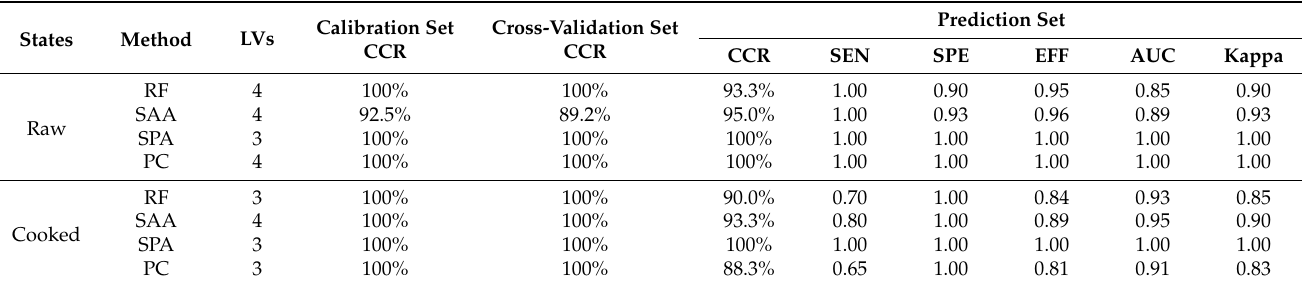
Table 3. Results of PLS-DA models using selected effective wavelengths. LVs: latent variables; CCR: correct classification rate; SEN: sensitivity; SPE: specificity; EFF: efficiency; AUC: area under the receiver operating characteristics curve; Kappa: Kappa coefficient.